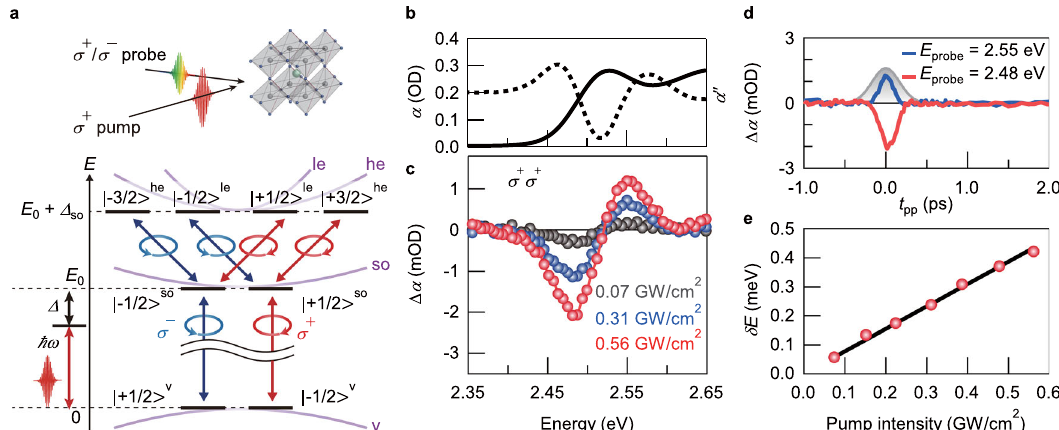
Fig. 1 Optical transitions and two-level OSE for Δ = 0.20 eV in CsPbBr 3 NCs. a Illustration of the circularly polarized pump – probe con fi guration (top) and the cubic CsPbBr 3 band structure around the R point (bottom). The light electron, heavy electron, and split-off CBs, and valence band are denoted by le, he, so, and v, respectively. The transition selection rules between band-edge states and between CB states are shown. The detuning energy Δ is de fi ned as the difference between the pump energy _ ω and the band-edge exciton transition energy E 0 . b Absorption spectrum of the CsPbBr 3 NCs (solid curve, left axis) and its second derivative (dashed curve, right axis). c Change in the absorption spectra obtained at t pp = 0 ps in the σ + σ + con fi guration for three different pump intensities. The pump is red-detuned from the band-edge exciton peak by 0.20 eV. d Transient absorption dynamics probed at 2.48 and 2.55eV for a pump intensity of 0.56 GW/cm 2 . The gray-shaded region shows the cross-correlation between the pump and probe pulses. e Pump intensity dependence of the estimated energy shift of the band-edge exciton. The black line shows the fi tting